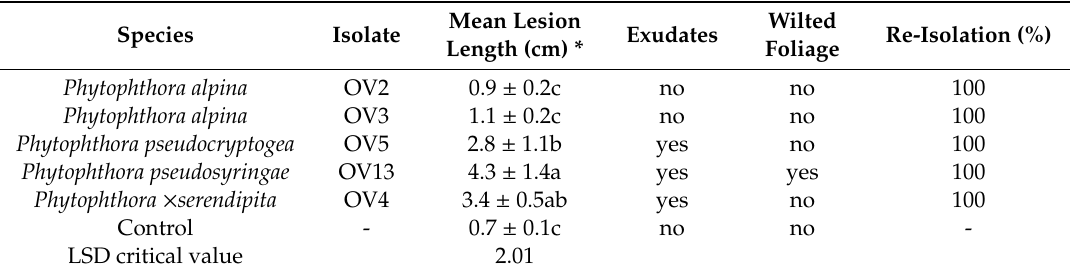
Table 4. Mean lesion length ± standard deviation caused by each Phytophthora species on green alder